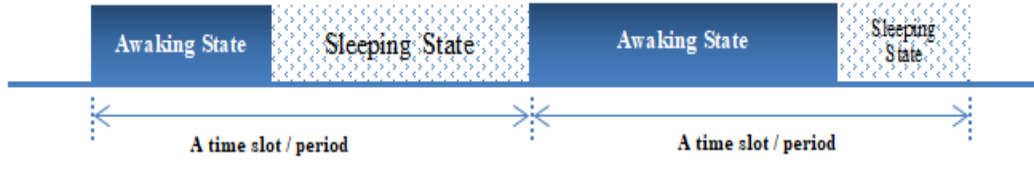
Figure 2. Description of the